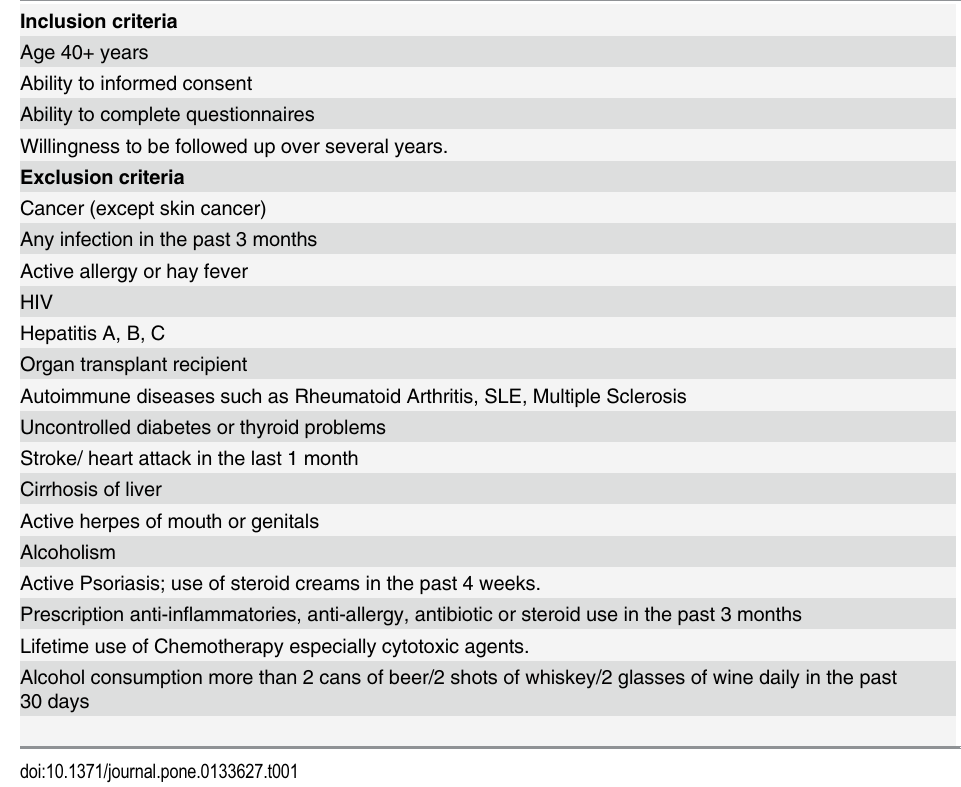
Table 1. Study inclusion and exclusion criteria.